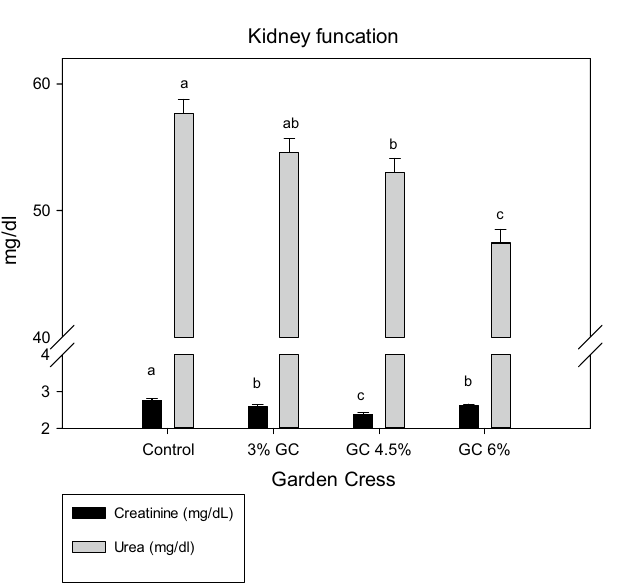
Figure 4. Effect of dietary levels of garden cress seeds on serum kidney function of doe rabbits.